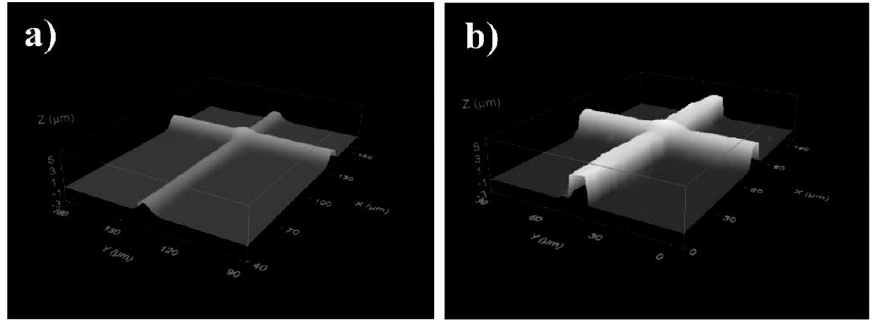
Figure 10. Topography images of crossing lines generated by direct laser writing using a formulation comprising the macromonomer: ( a ) linear-YNE and ( b ) star-YNE PLAs, both with a stoichiometric amount of the thiol (stoichiometry alkyne/thiol 1:2) and 3 wt % of photoinitiator. Images were obtained using a confocal microscope [107]. (Adapted with permission from Elsevier, 2017).